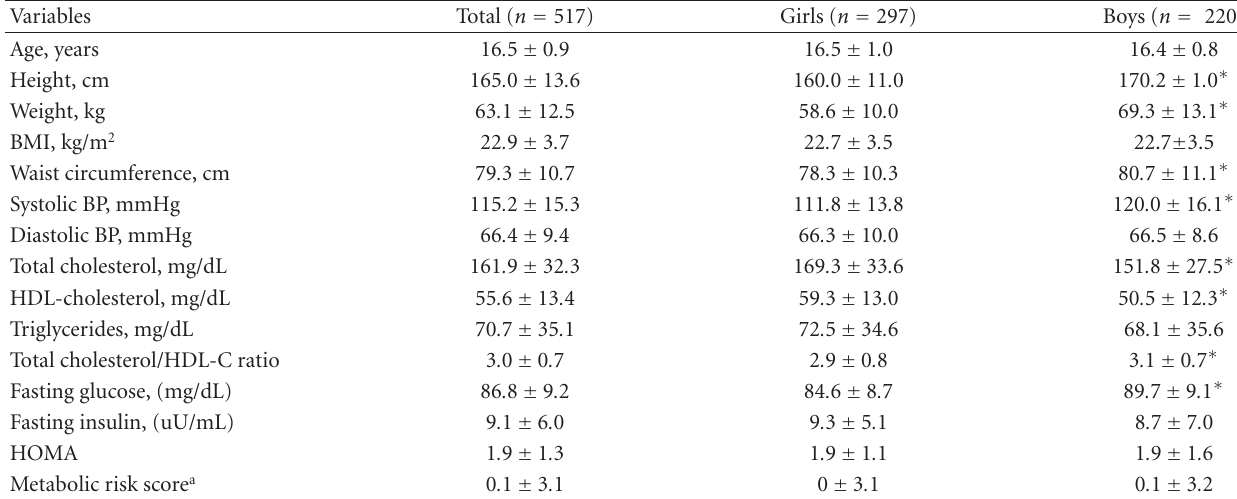
Table 1: Descriptive characteristics of the study